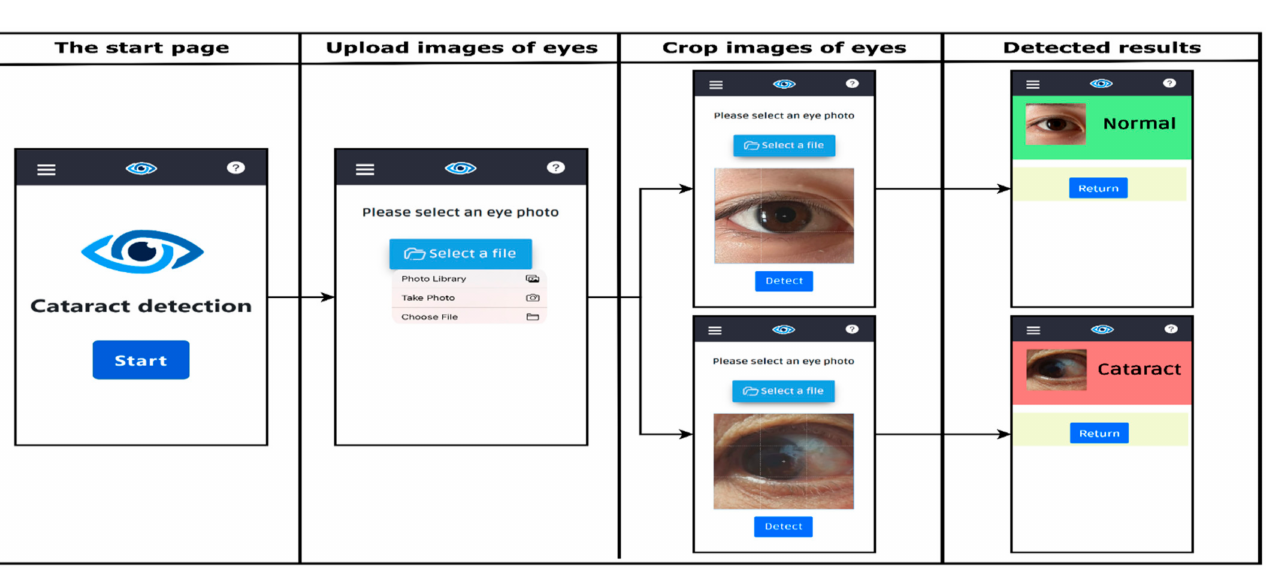
Figure 4. Four steps of the graphical user interface with